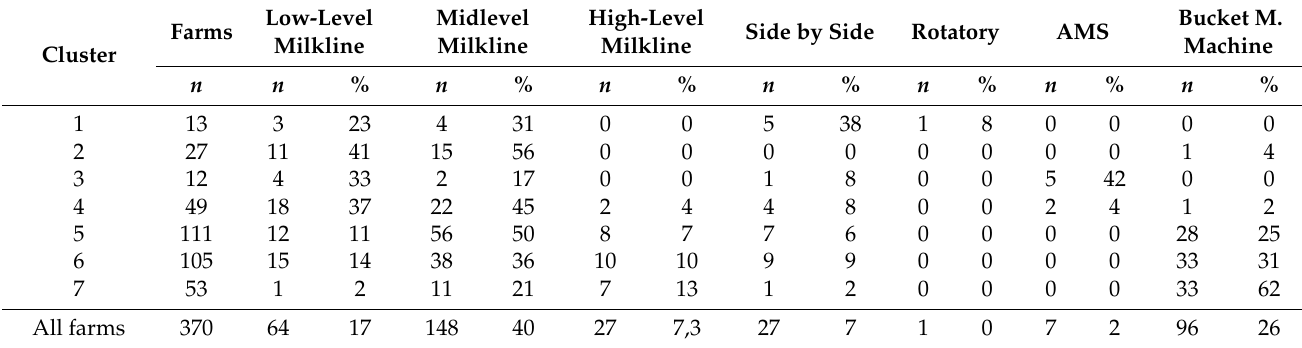
Table 4. Milking machine system used by farms